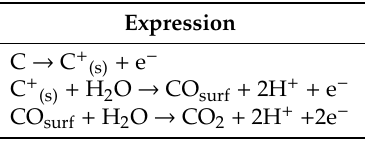
Figure 1. Triple phase boundary of membrane electrode assembly ( a ) before online conditioning; and ( b ) after online conditioning. Table 1. Carbon oxidation reaction of carbon support.